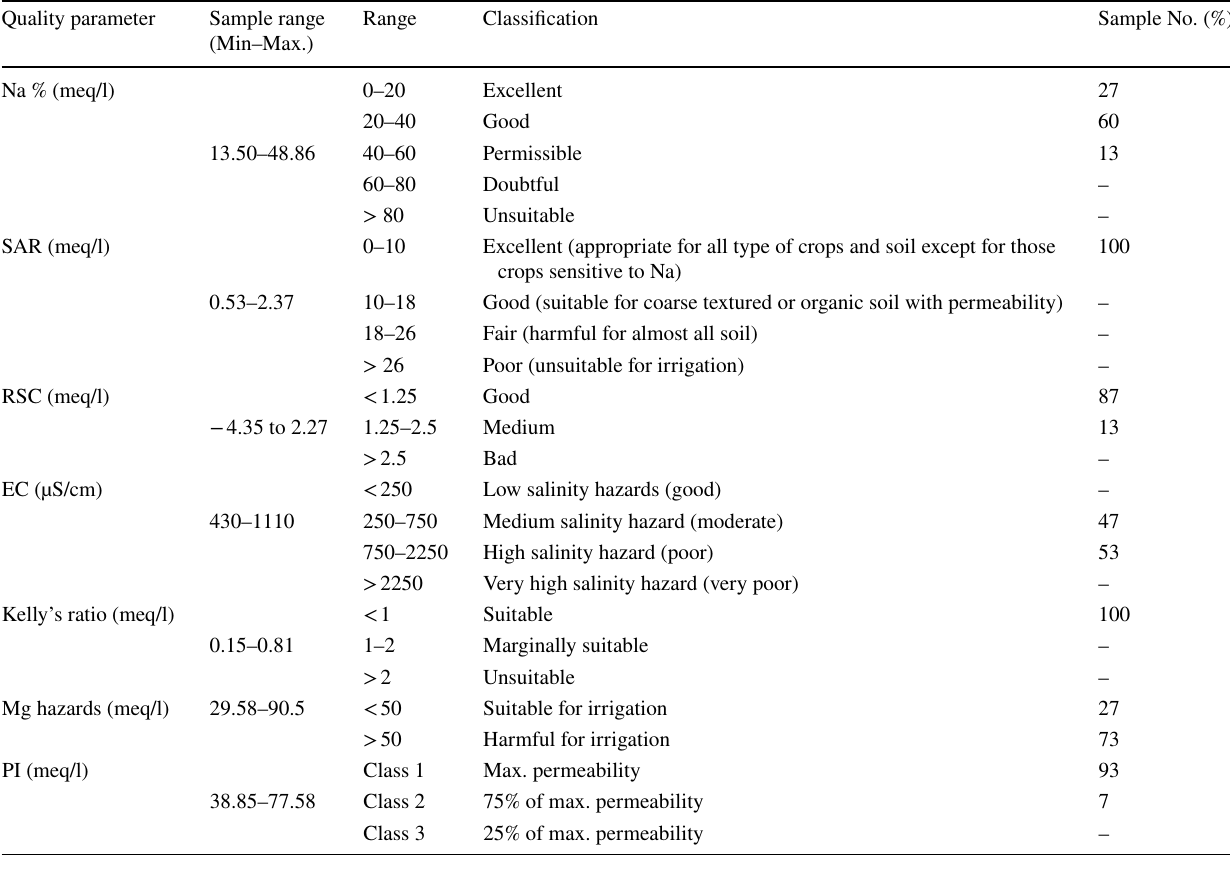
Table 5 Categorization of groundwater samples for irrigational purposes Quality parameter